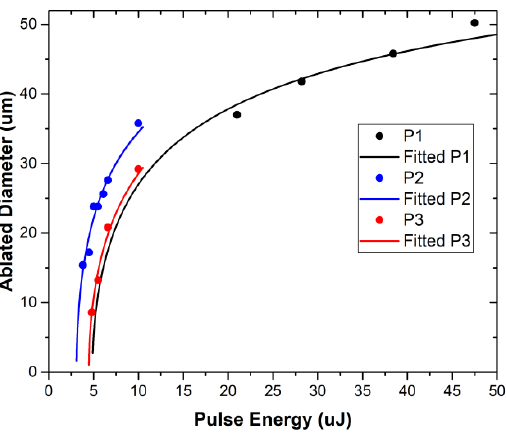
Figure 4. Laser ablation threshold measurement and fitted curves produced for a focused spot size of ~45 μ m and a 532 nm wavelength.